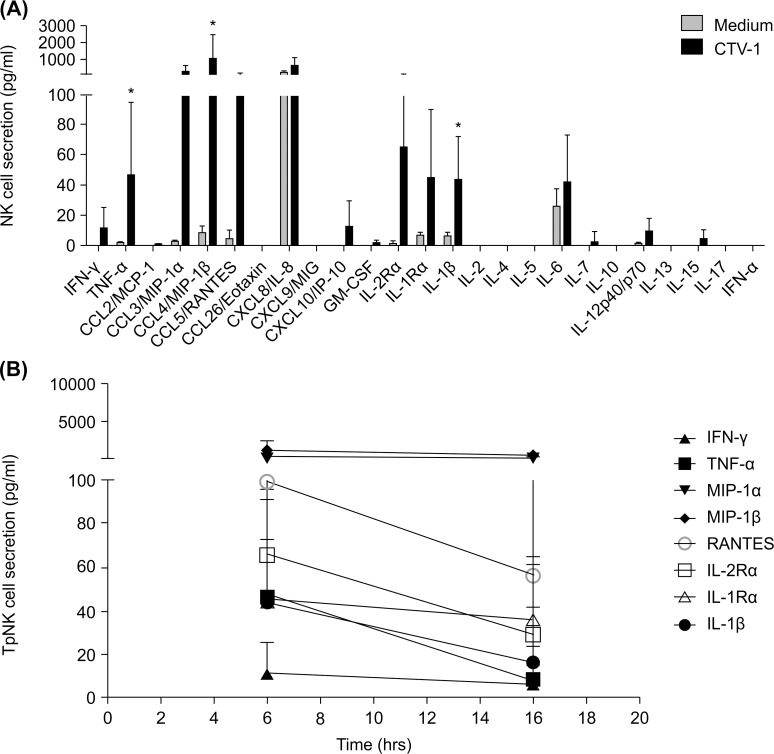
Influence of CTV-1 cell priming on pro-inflammatory cytokine secretion by NK cells.(A) Freshly isolated NK cells were incubated alone or with CTV-1 cells for 6 hours at 37°C. Supernatants were harvested, and the concentrations of 25 different cytokines and chemokines were determined using a multiplex immunoassay. Bars represent means ± SD of 4 different donors. Post-stimulation cytokine secretion by NK cells was compared with that of cells incubated in medium alone using the paired t-test. Statistical significance is indicated as: *P <0.05; **P <0.01; ***P <0.001. (B) NK cells were incubated with CTV-1 cells at 37°C. Supernatants were harvested at different time points, as indicated, and the concentrations of IFN-γ, TNF-α, MIP-1α, MIP-1β, and RANTES were determined by a multiplex immunoassay. Values represent mean ± SD of 4 different donors.